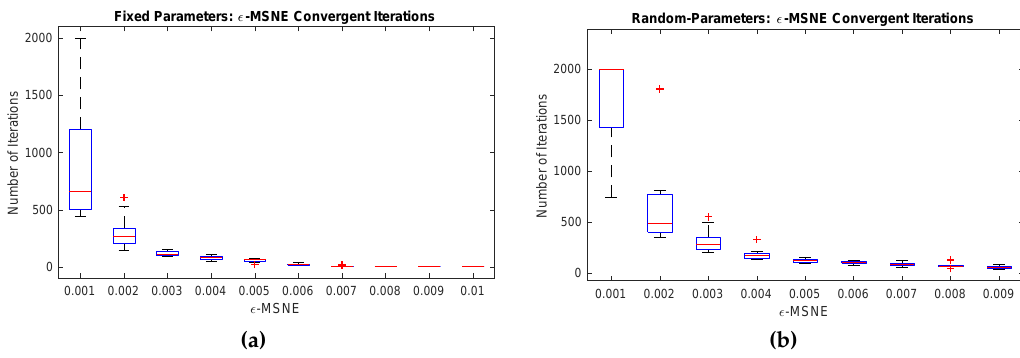
Figure 3. Convergence Rate of Best-Response Gradient Dynamics ( BRGD ) Heuristic for Computing an Approximate Mixed Strategy Nash Equilibrium ( MSNE ). The plots in this figure present the number of iterations of BRGD as a function of (cid:101) under the two experimental conditions: Internet games with fixed ( a ) and randomly-generated parameters ( b ). Applying mean-squared-error ( MSE ) regression to the left-hand and right-hand graphs, we obtain a functional expression for the number of iterations N F ( (cid:101) ) = 0.00003 (cid:101) − 2.547 ( R 2 = 0.90415) and N R ( (cid:101) ) = 0.0291 (cid:101) − 1.589 ( R 2 = 0.9395), respectively (i.e., low-degree polynomials of 1/ (cid:101)